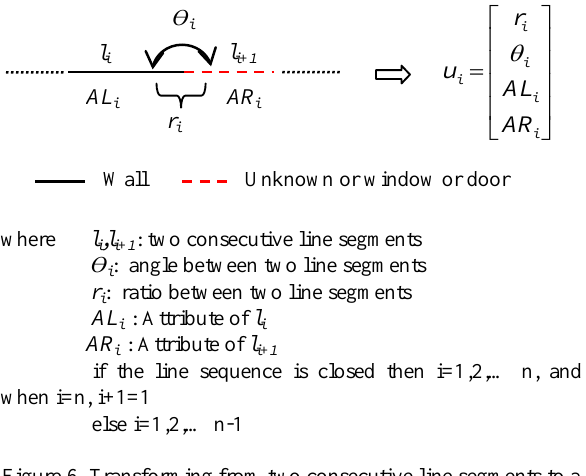
Figure 6. Transforming from two consecutive line segments to